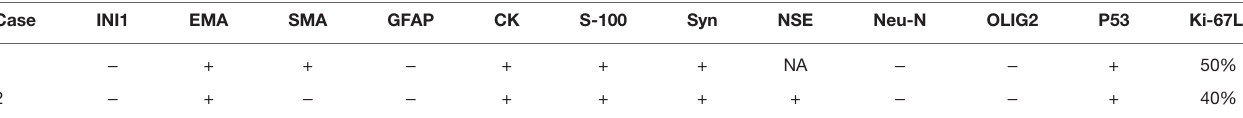
TABLE 2 | Immunohistochemical staining in two cases of